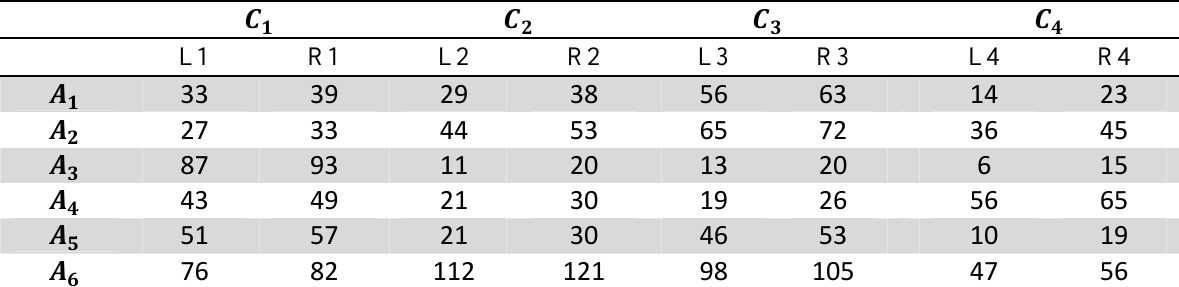
Interval decision matrix